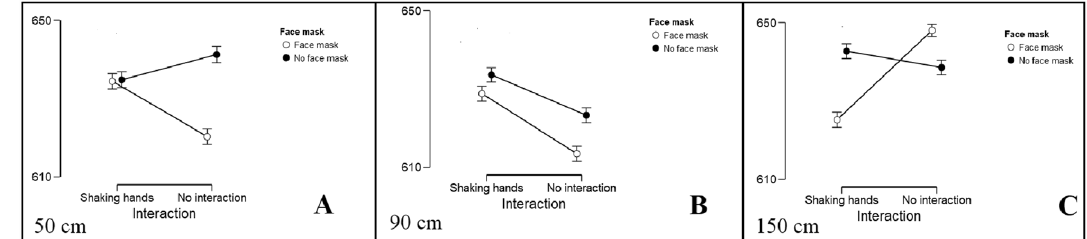
Figure 2. Reaction times [ms] as a function of face mask and interaction style in all three distances (50 cm/ near, 90 cm/middle, 150 cm/far). Panel ( A ) 50 cm. Panel ( B ) 90 cm. Panel ( C ) 150 cm. Error bars denote one standard deviation of the mean.